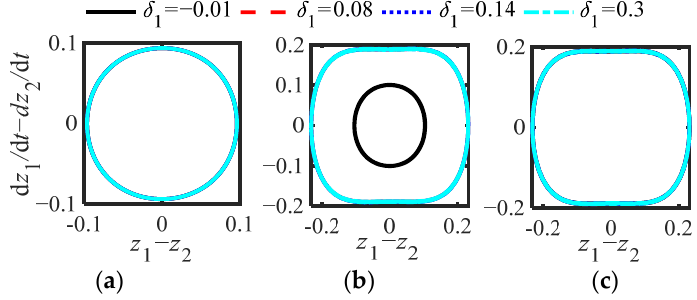
Figure 17. Phase diagrams ( κ = 1.1) of (6) at different δ 1 : ( a ) T 1 , ( b ) T 2 , ( c ) T 3 .